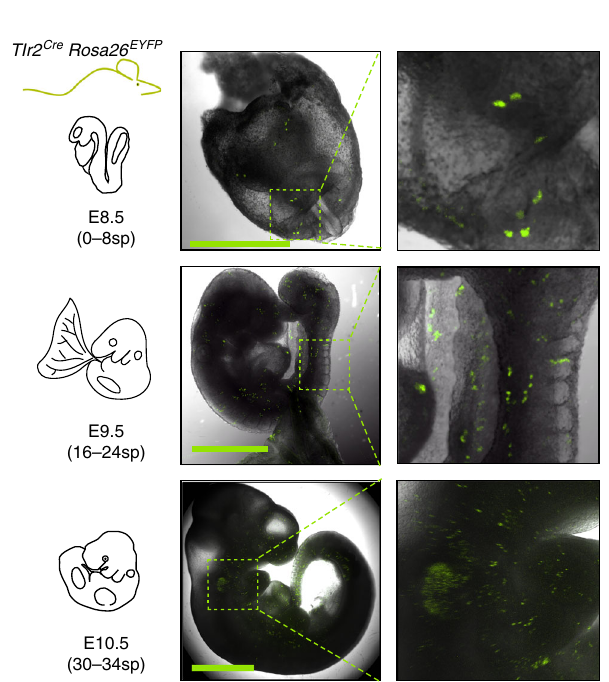
Fig. 2 Lineage tracing shows early activation of Tlr2 locus in hematopoietic progenitors. Spatial microscopic analysis of E8.5 – E10.5 Tlr2 Cre EYFP + cells; scale bar = 1 mm. Representative image is shown ( n = 3 independent experiments with 3 – 6 embryos per